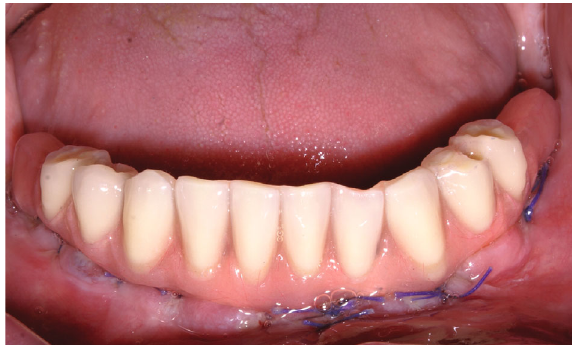
Figure 3: Interim prosthesis immediately after